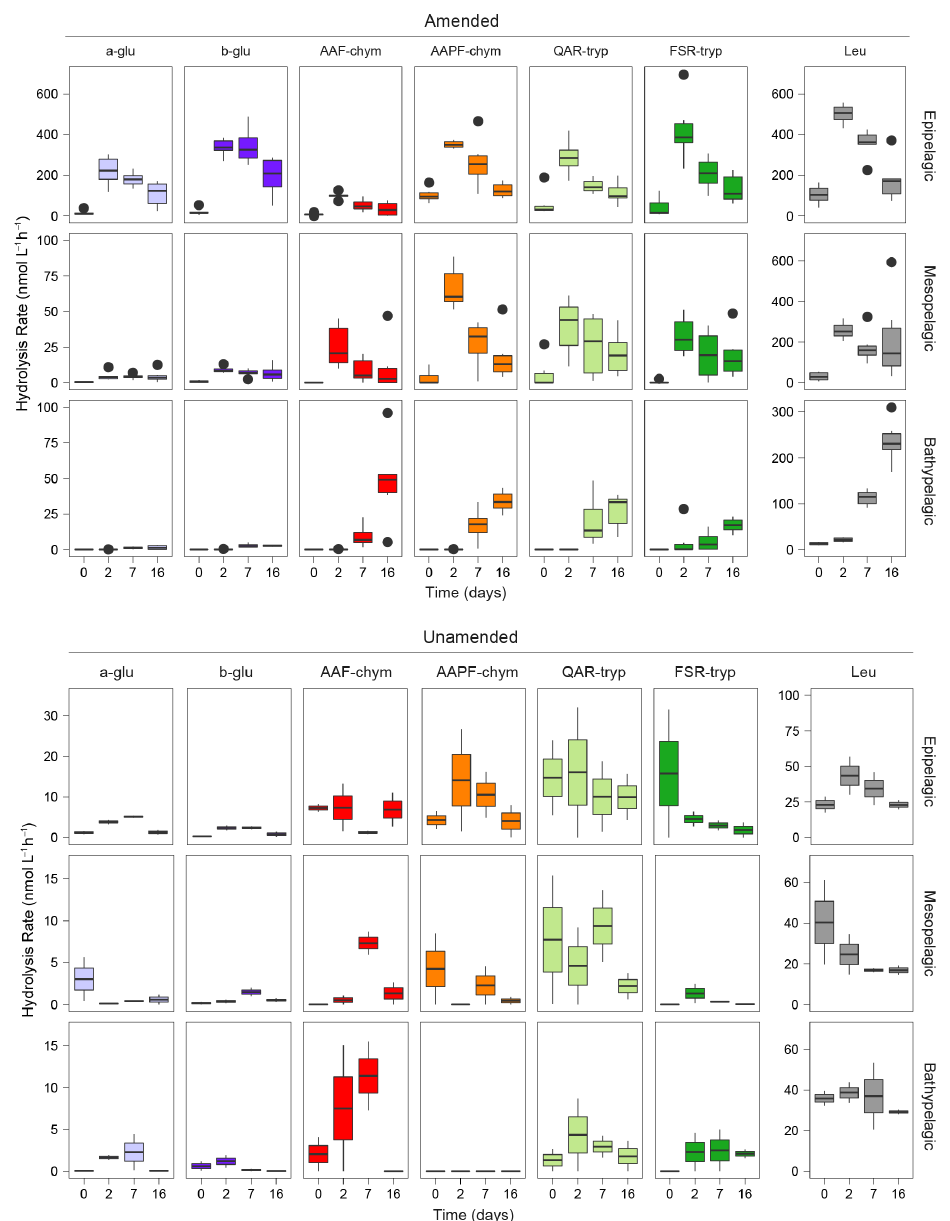
Figure 1. Peptidase and glucosidase activities in amended and unamended mesocosms 0, 2, 7, and 16d after the addition of HMW organic matter to amended mesocosms. Rates are an average between the two stations. Note the difference in scales between the amended and unamended mesocosms. a-glu: α -glucose, b-glu: β -glucose, AAF-chym: AAF (chymotrypsin), AAPF-chym: AAPF (chymotrypsin), QAR- tryp: QAR (trypsin), FSR-tryp: FSR (trypsin), and Leu: